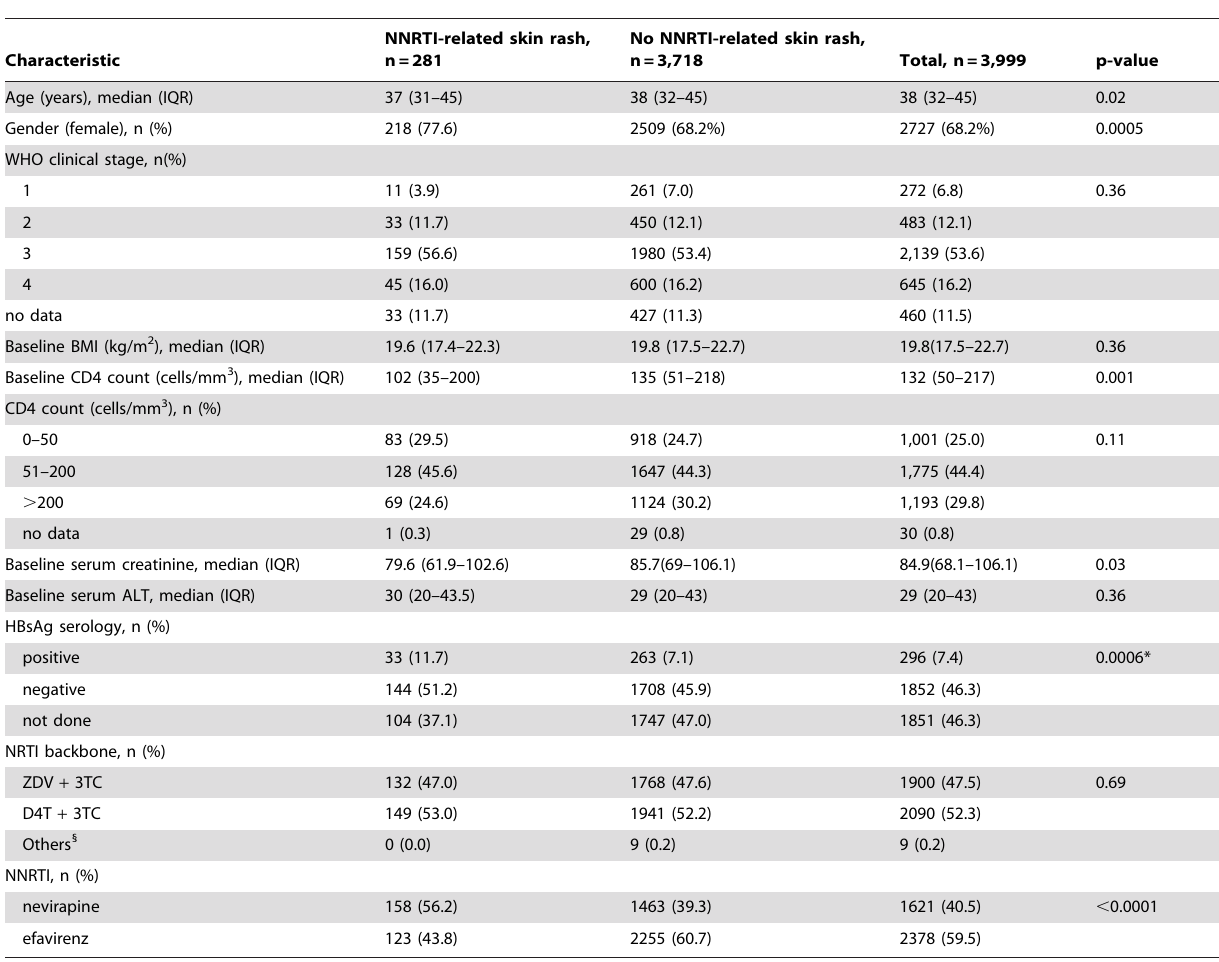
Table 1. Baseline characteristics of patients with and without a NNRTI-related skin rash.